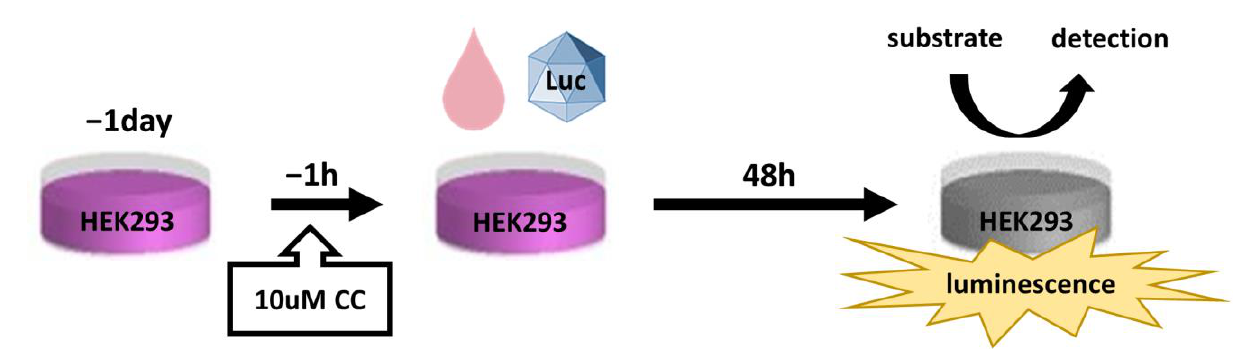
Figure 1. Schematic outline of the experimental procedure neutralizing antibody assay.